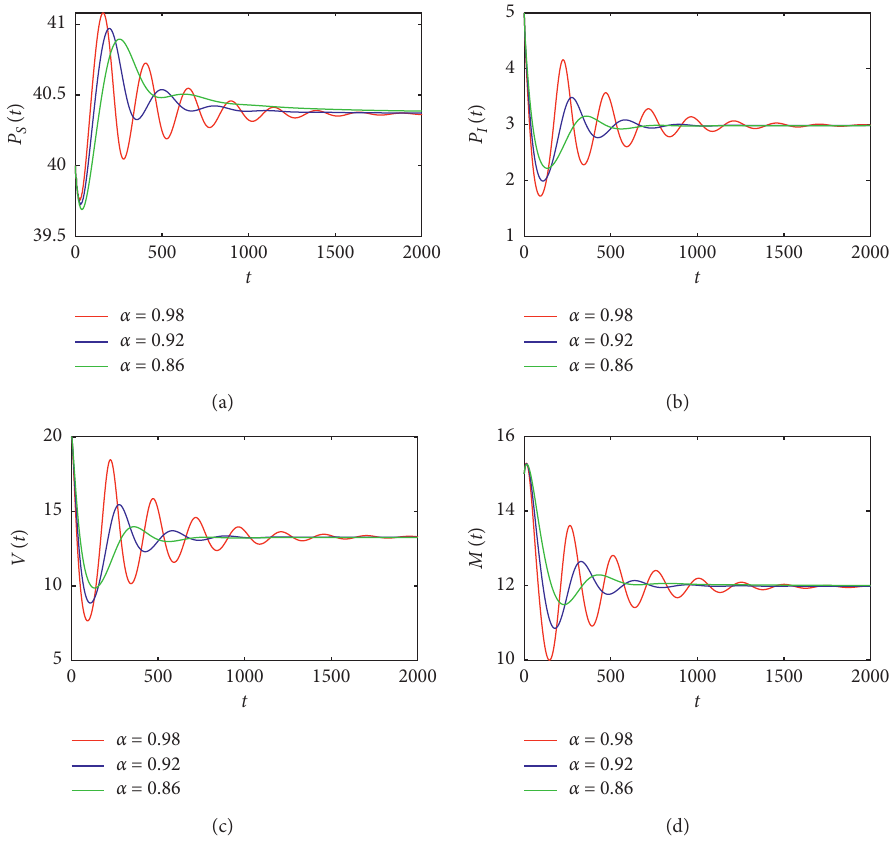
Figure 8: The time series of system (5) when α � 0.98, α � 0.92, α � 0.86, k � − 2, δ � 4 . 8, and τ �